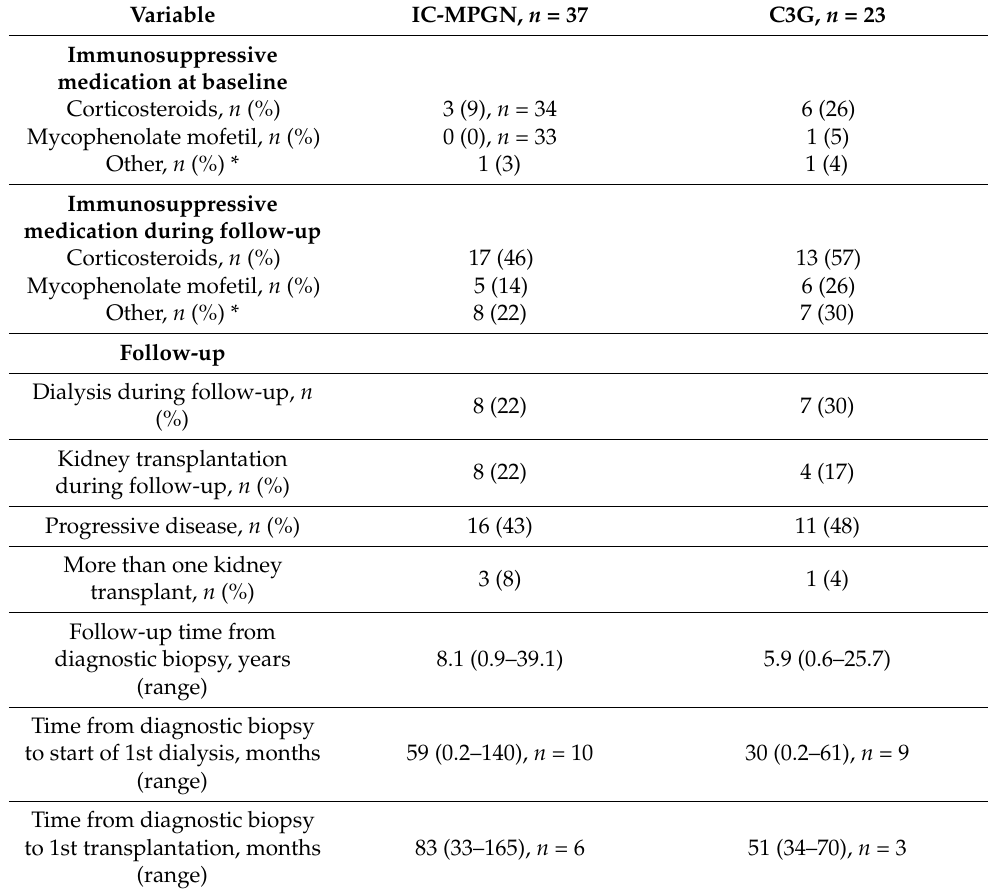
Table 5. Treatment, including medications at baseline and during follow-up as well as data on kidney replacement therapy and follow-up. Values are expressed as means (range or SD) or num- bers (percentage) of patients. Number of patients signifies the maximum number of patients with the information. Unless otherwise indicated, the variable numbers were available for all patients. Immunosuppressive medication denotes treatment aimed at kidney disease (not due to kidney transplantation). Differences between the groups were not significant ( p > 0.05 for all